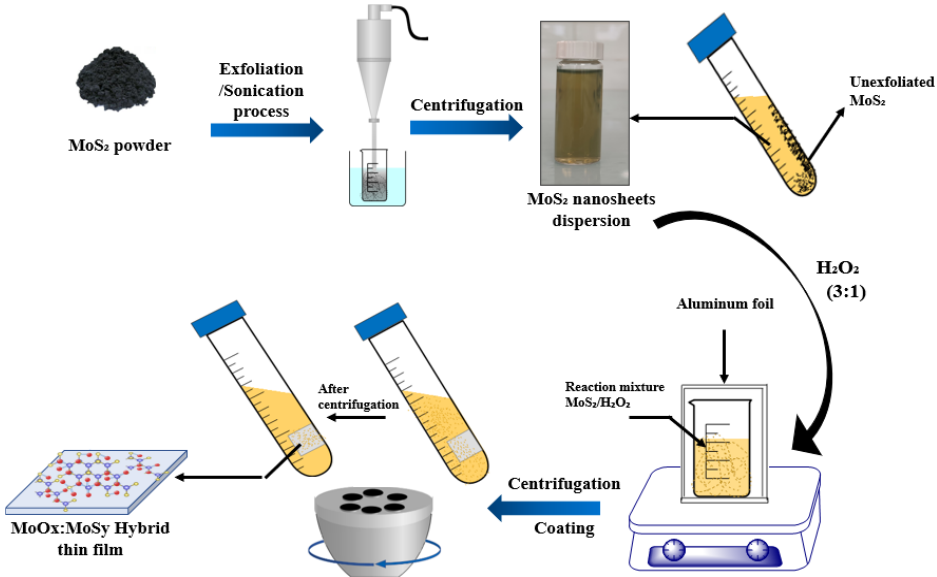
Figure 1. Schematic illustration of MoS 2 exfoliation and hybrid thin film preparation by centrifugation-coating .